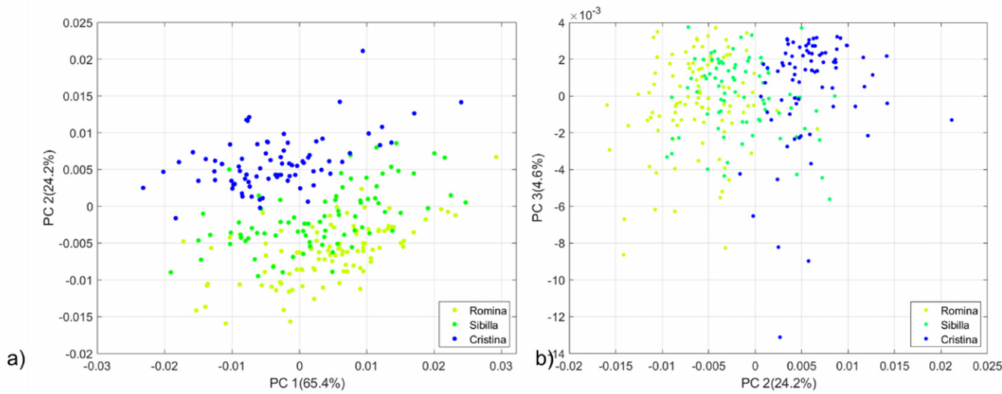
Figure 1. ( a ) Principal Component Analysis (PCA) score plot of the five strawberry genotypes (PC1 vs PC2); ( b ) PCA score plot of the five strawberry genotypes (PC2 vs PC3). Spectra were pre-treated with first derivative (Savitzky–Golay filter, 21 smoothing points, 2nd polynomial order). PC = principal component.